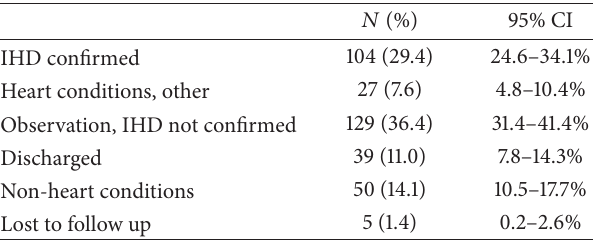
Table 4: Non-heart conditions ( 𝑛 = 50 ).